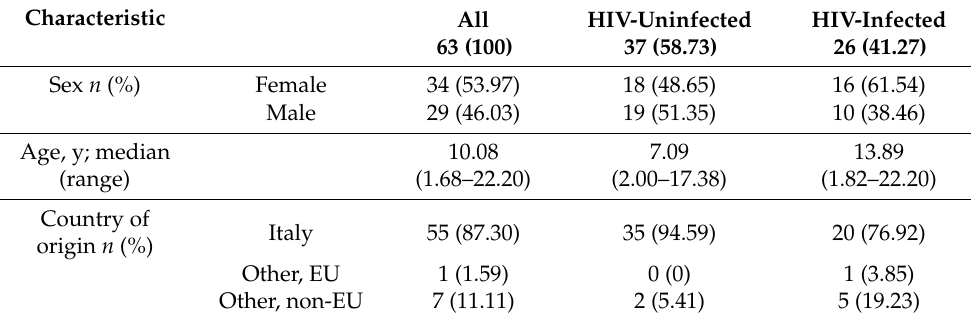
Table 1. Population demographic at